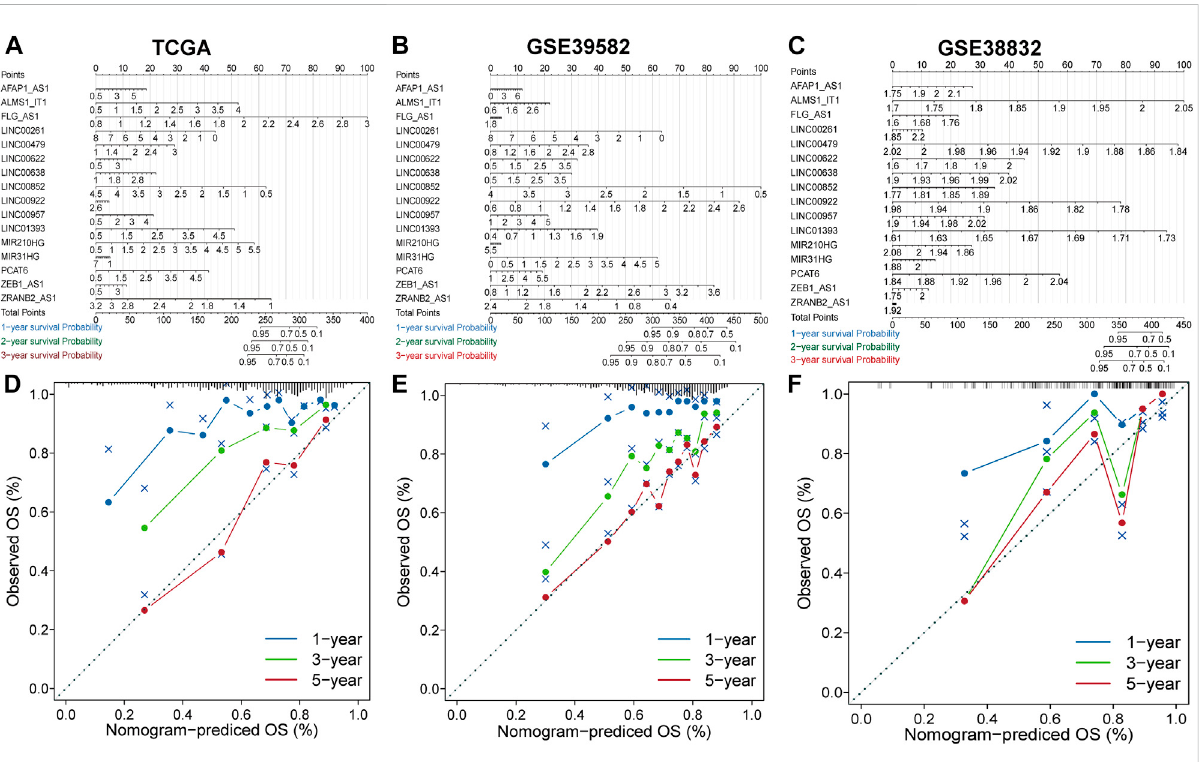
FIGURE 3 Construction and evaluation of prognostic nomograms and calibration curves (A – C) The nomogram predicts the probability of 1-, 3-, and 5- years OS. (D – F) The calibration plot of the nomogram predicts the probability of 1-, 3-, and 5-years